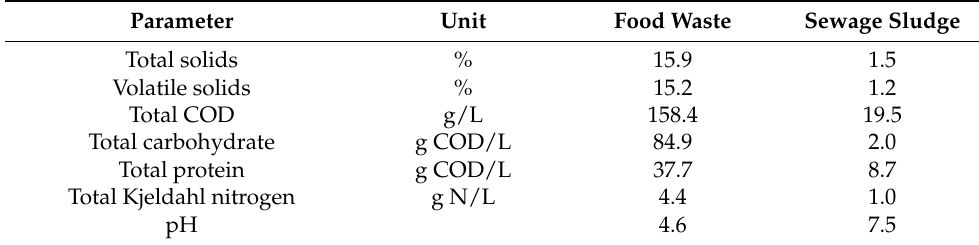
Table 1. Characteristics of food waste and sewage